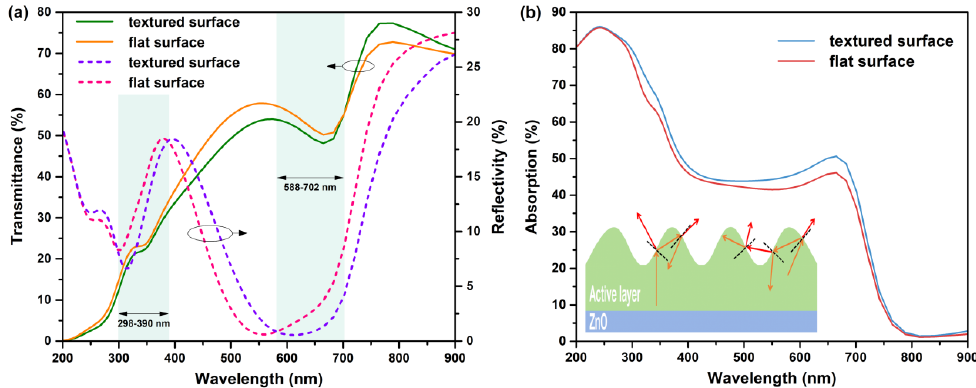
Figure 3. ( a ) Transmission and reflection spectra of the blend films with textured and flat surface and ( b ) corresponding absorption spectra. The inset shows the light-trapping mechanism of the textured surface.